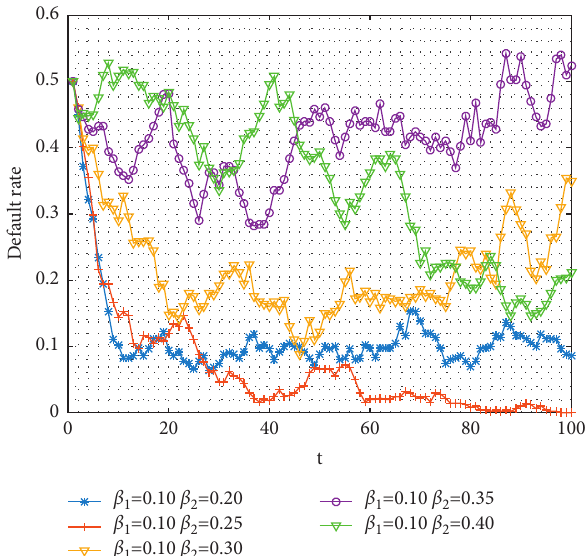
Figure 1: Diffusion of default behavior in a small-world network with the increase of β